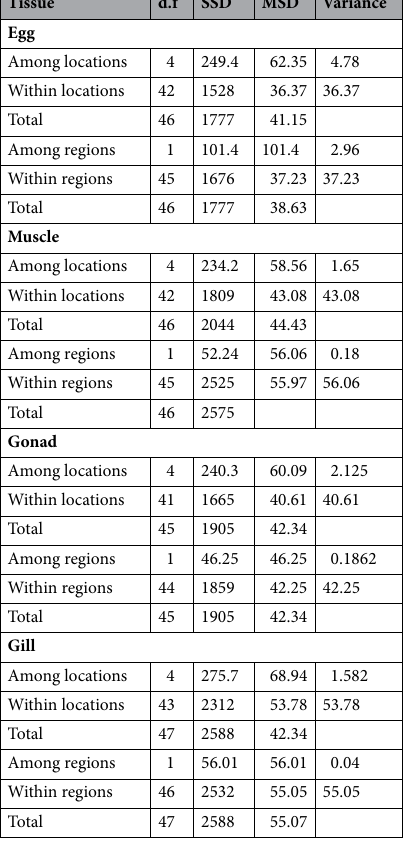
Tissue d.f SSD MSD